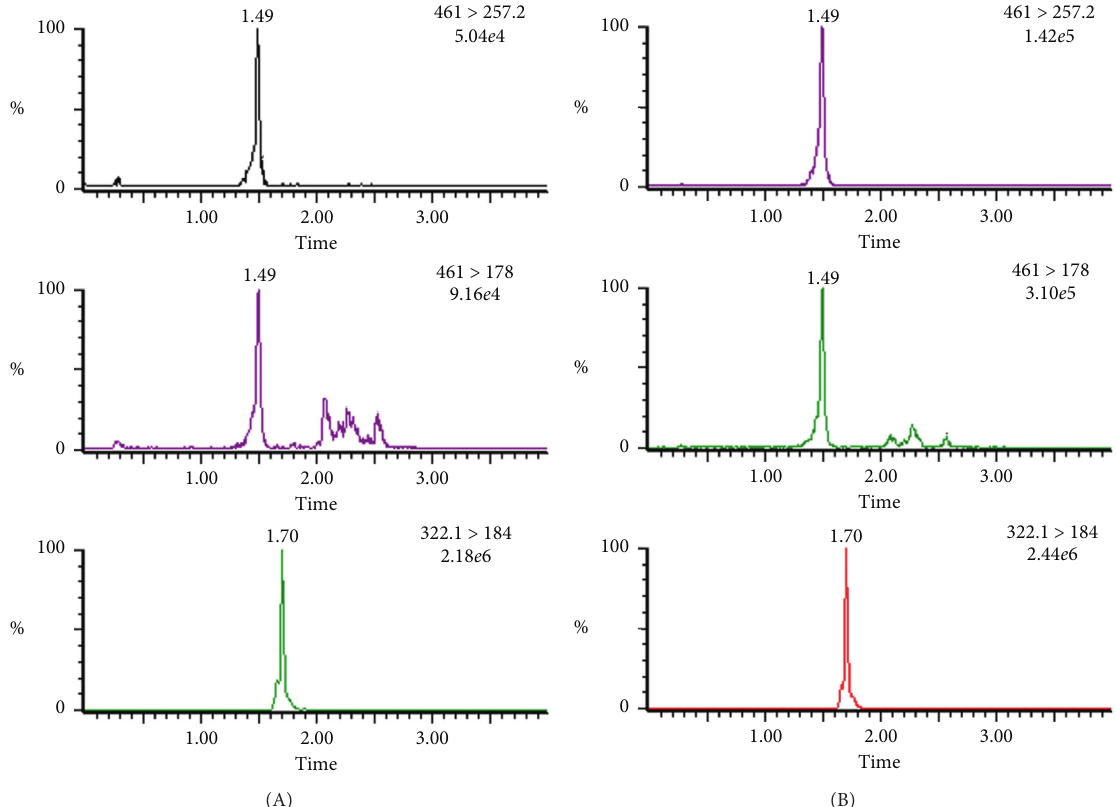
Figure 3: Representative chromatograms of apremilast and its IS in (A) blank beagle dog plasma spiked with working solutions at 2 ng mL − 1 of apremilast and 100ng L − 1 of IS and (B) beagle dog plasma samples collected at 0.5h after oral administration of apremilast at 30mg · day − 1